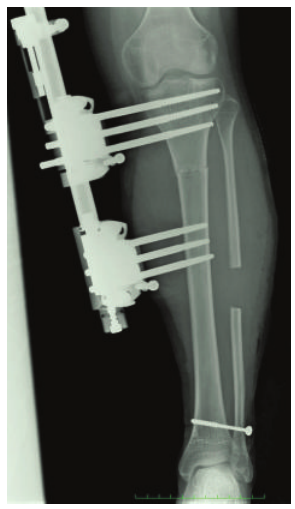
Figure 2: Radiographs of entire lower limbs before leg lengthening showed tip of the residual left femur had moved upward about 4 cm in standing position (a) compared with the right leg (b).